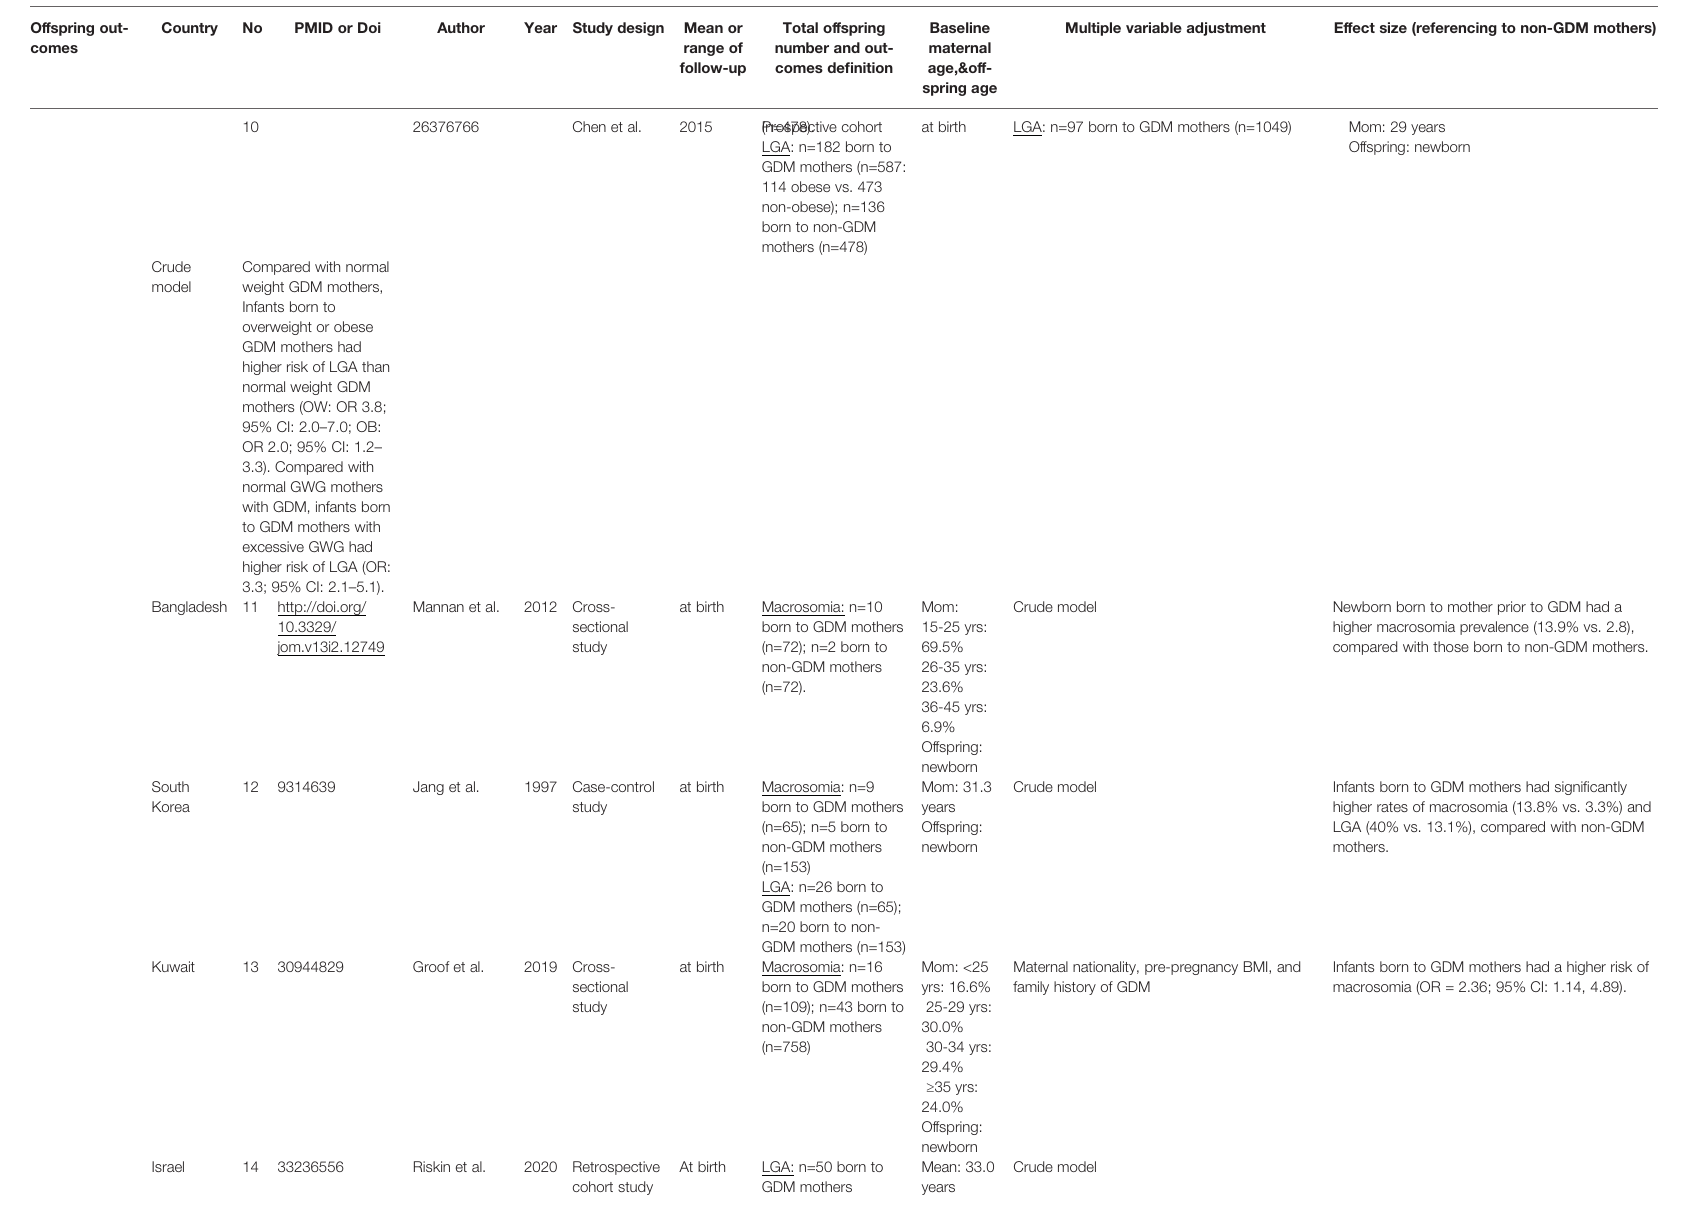
2020 Retrospective cohort study